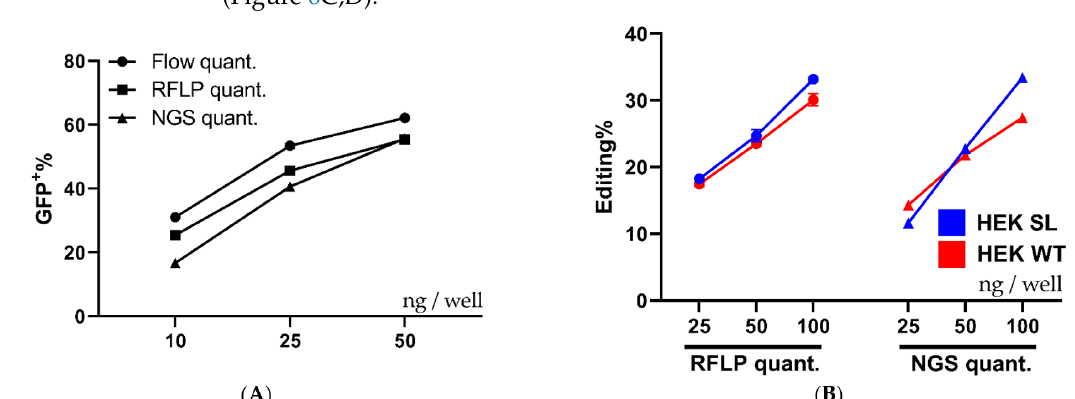
Figure 5. Comparison of quantification techniques and cell types. ( A ) Shows a comparison between different quantification techniques, flow cytometry, RFLP, and NGS performed on the same samples of HEK293T SL cells treated with increasing amounts of RNP: PF14 complexes (MR 1:100 RNP to PF14). n = 1, with the flow cytometry done in triplicate, gel quant in duplicate, and NGS done in single samples. Part of the cells were analyzed by flow cytometry, the remainder of the cells were analyzed by RFLP and NGS after DNA purification and PCR amplification. ( B ) Displays the quantified editing of HPRT in HEK293T SL and HEK293T WT cells treated with increasing amounts of RNP: PF14 complexes (MR 1:100 RNP to PF14). The gRNA used targets the human HPRT gene. The quantification by RFLP and NGS was performed on the same samples. Gel quantification was performed in duplicate ( n = 1), while NGS was done a single time per treatment ( n = 1).